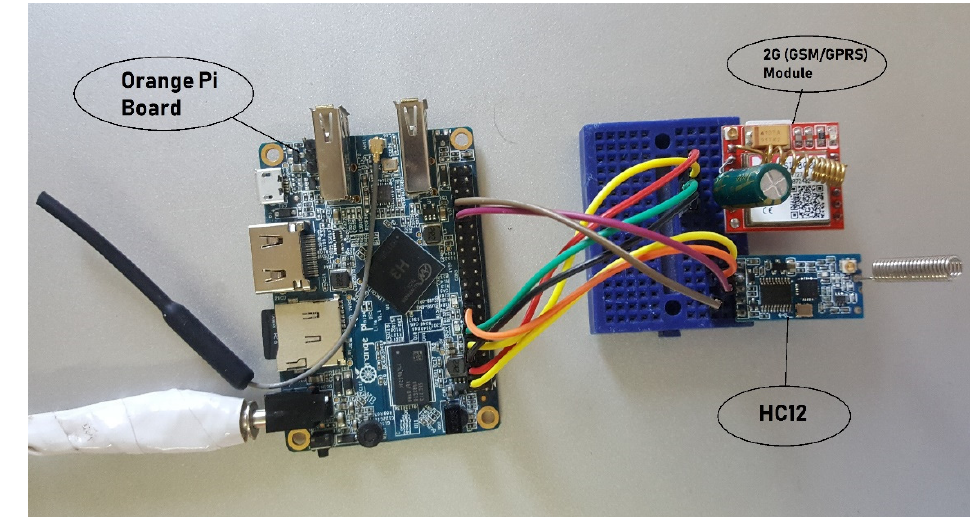
Figure 5. Physical diagram of gateway node